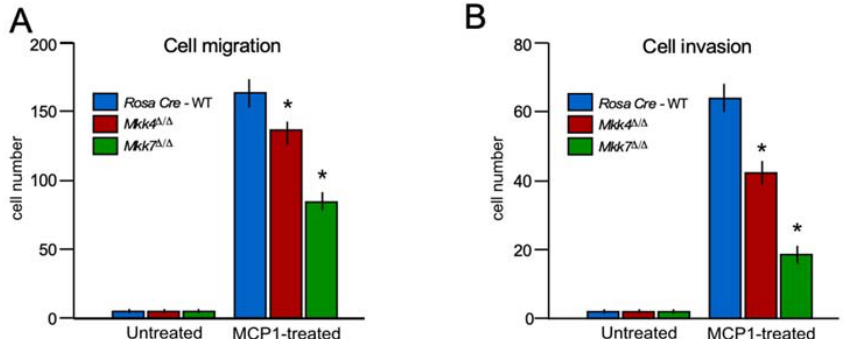
Figure 4. Role of MKK4 and MKK7 in cell migration and invasion. ( A , B ) A Transwell system was used to measure the migration ( A ) and Matrigel invasion assay ( B ) of Rosa26-Cre ERT , Mkk4 ∆ / ∆ and Mkk7 ∆ / ∆ BMDMs. (mean ± S.E.M.; n = 8); (*) p < 0.05 vs. WT. All the experiments were repeated 3–4 times.